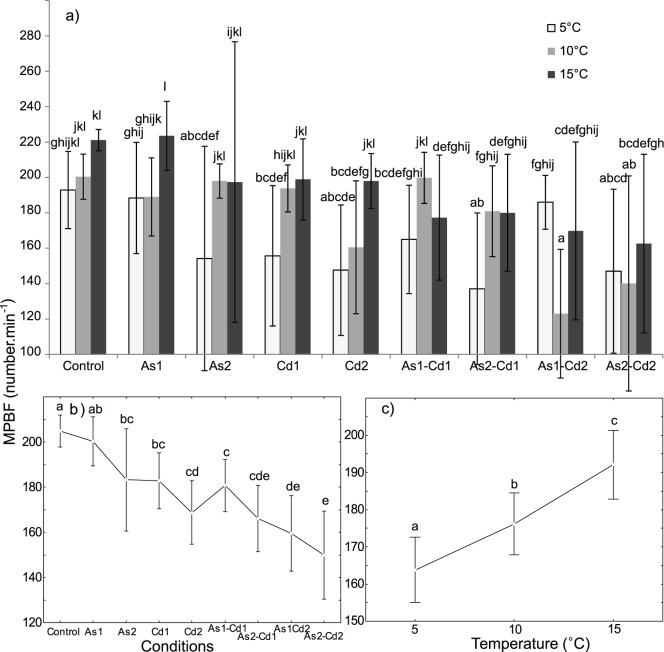
Mean pleopod beat frequency (MPBF) of Gammarus pulex.
PBF obtained for individuals exposed 96 h to different conditions (control, arsenate, cadmium and four binary mixtures) at three temperatures (5-10-15°C). a) Temperature × condition effect: Mean MPBF for each tested condition and temperature. Vertical bars represent standard deviations. b) Condition effect: Weighted mean MPBF for each tested condition (results for all the tested temperatures were combined). Vertical bars represent 0.95 confidence intervals. c) Temperature effect: Weighted mean MPBF for each temperature (results for all the tested conditions were combined). Vertical bars represent 0.95 confidence intervals. Letters (a to l) were used as labels to illustrate significant differences in MPBF values (two-ways ANOVA + LSD Fisher post hoc tests; at p<0.05 level of significance).